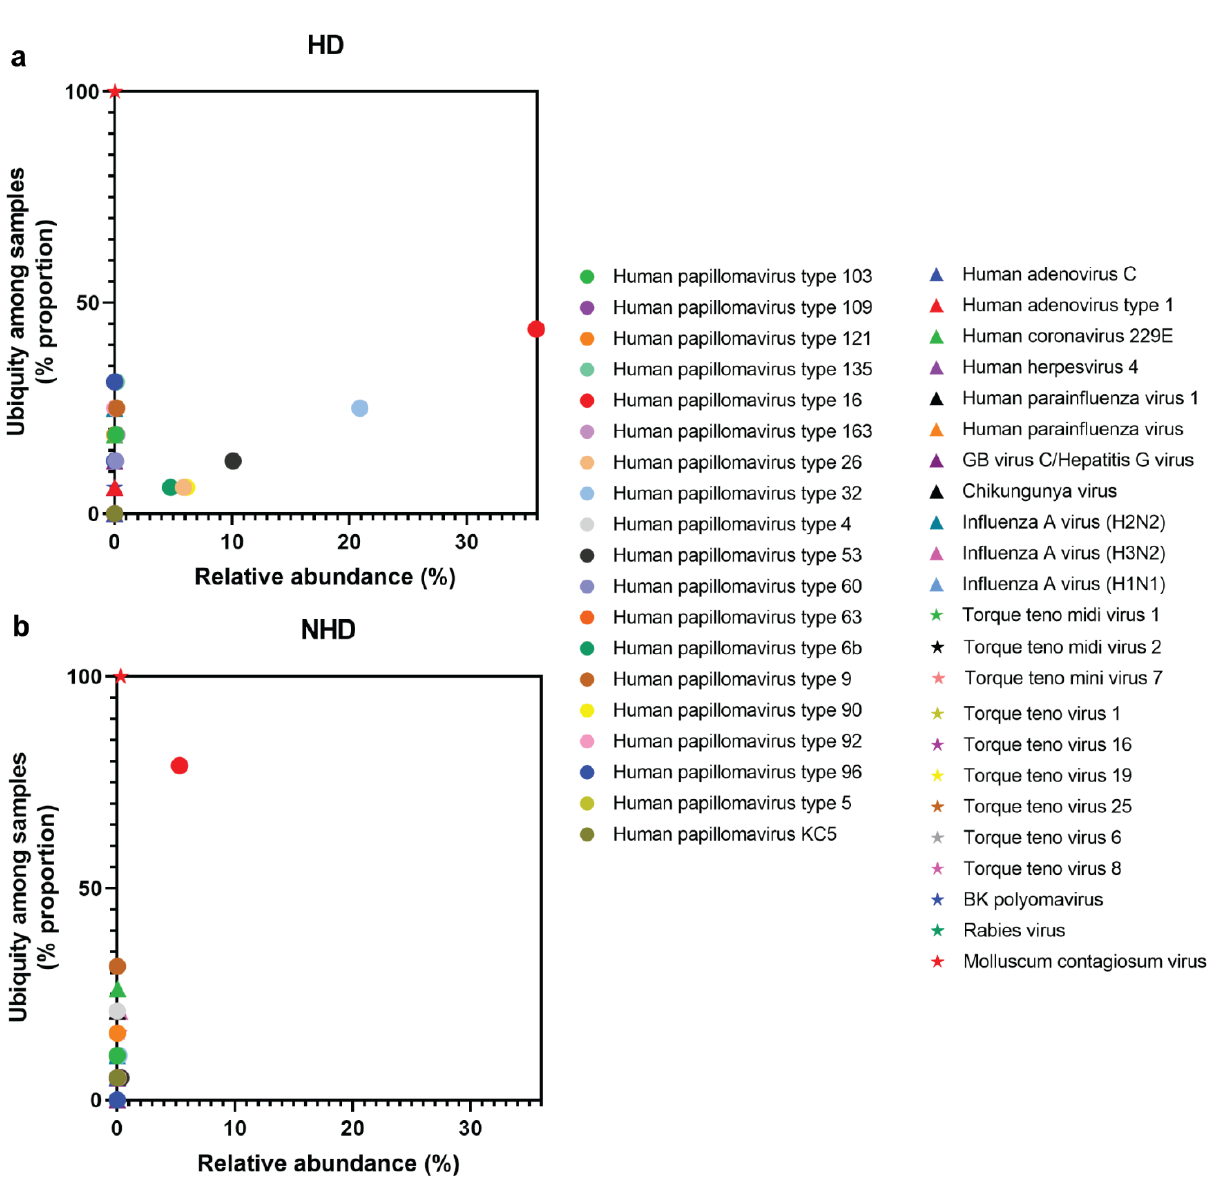
Figure 5. Ubiquity dot plots representing viral species in the cervix between HD (a) and NHD (b) groups. The graphs were plotted between the mean of ubiquity (y axis) and relative abundance (x axis) from e ach species. (● =HPVs, ▲ and = Other human viruses).